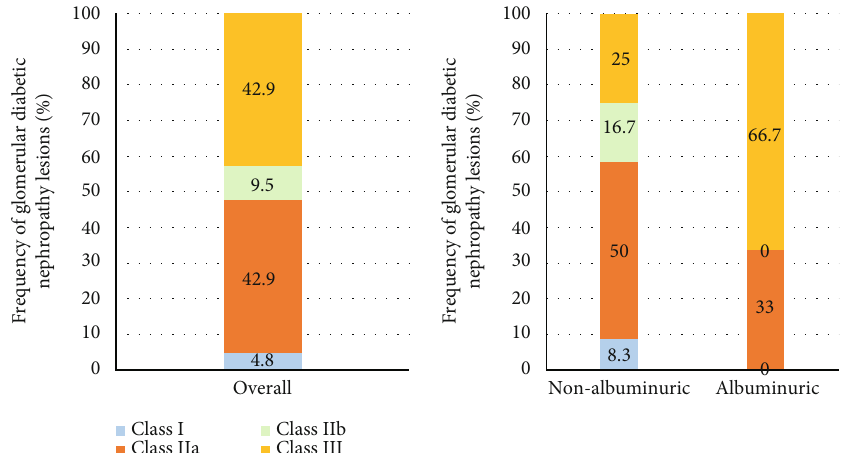
Figure 4: Frequency of di ff erent classes of glomerular diabetic nephropathy lesions. Frequency of di ff erent classes of glomerular diabetic nephropathy lesions in all diabetic patients (left panel). The right panel shows the di ff erent classes according to albuminuric status ( n = 21